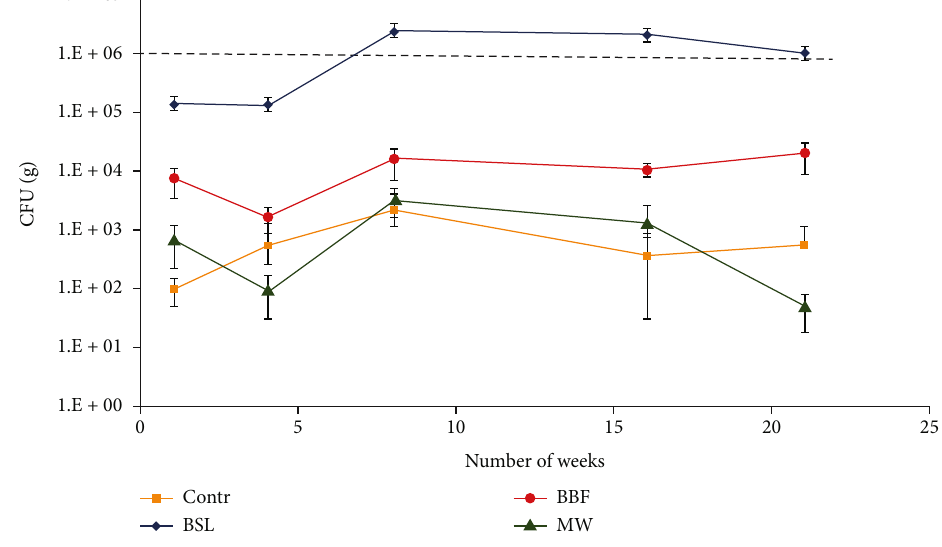
Figure 2: Mesophilic aerobic microbial cell count changes over